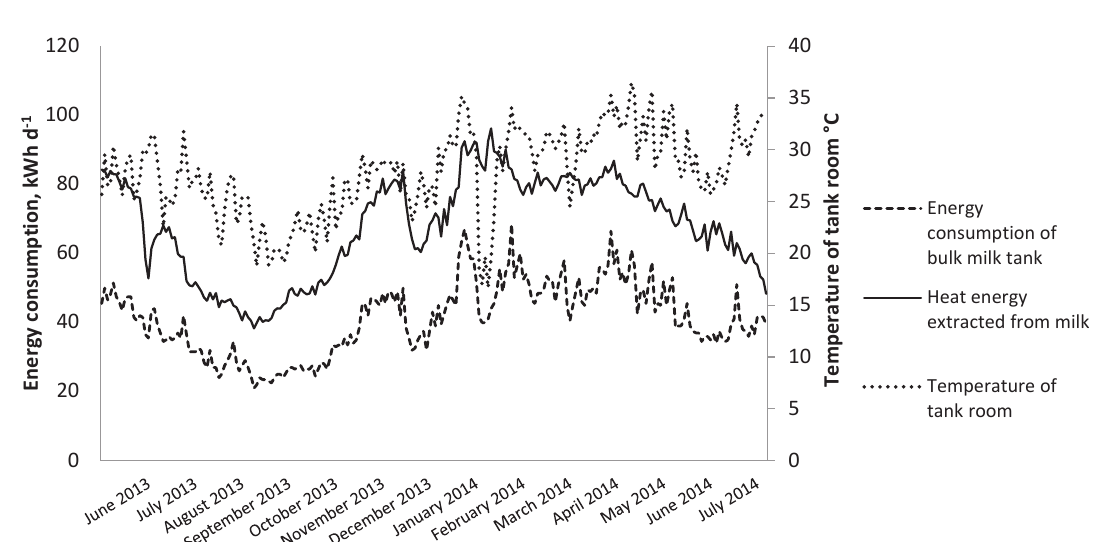
Fig. 3. Daily electricity consumption of the milk tank refrigeration system, amount of heat energy extracted from milk and temperature of the tank room on farm I from May 2013 to June 2014